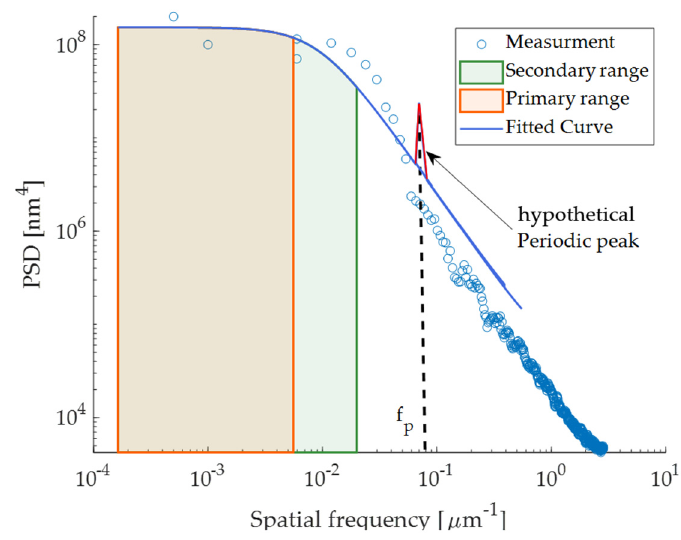
Figure 10. The effective frequency range of the PSD for the primary and the secondary.